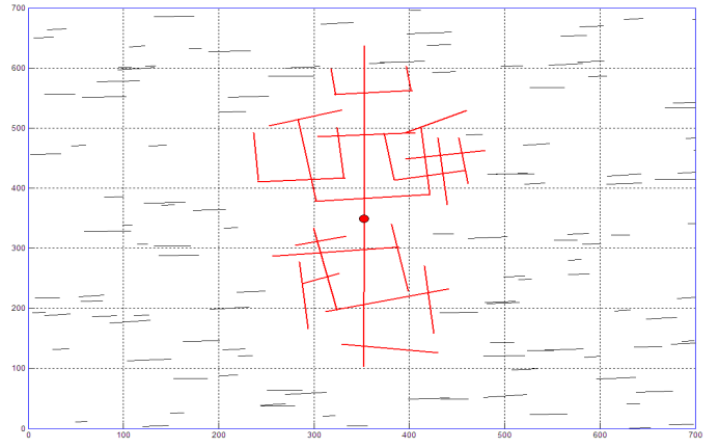
Figure 10. The simulation results of UFM. (The red dot refers to the wellbore and the red lines refer to the fractures).